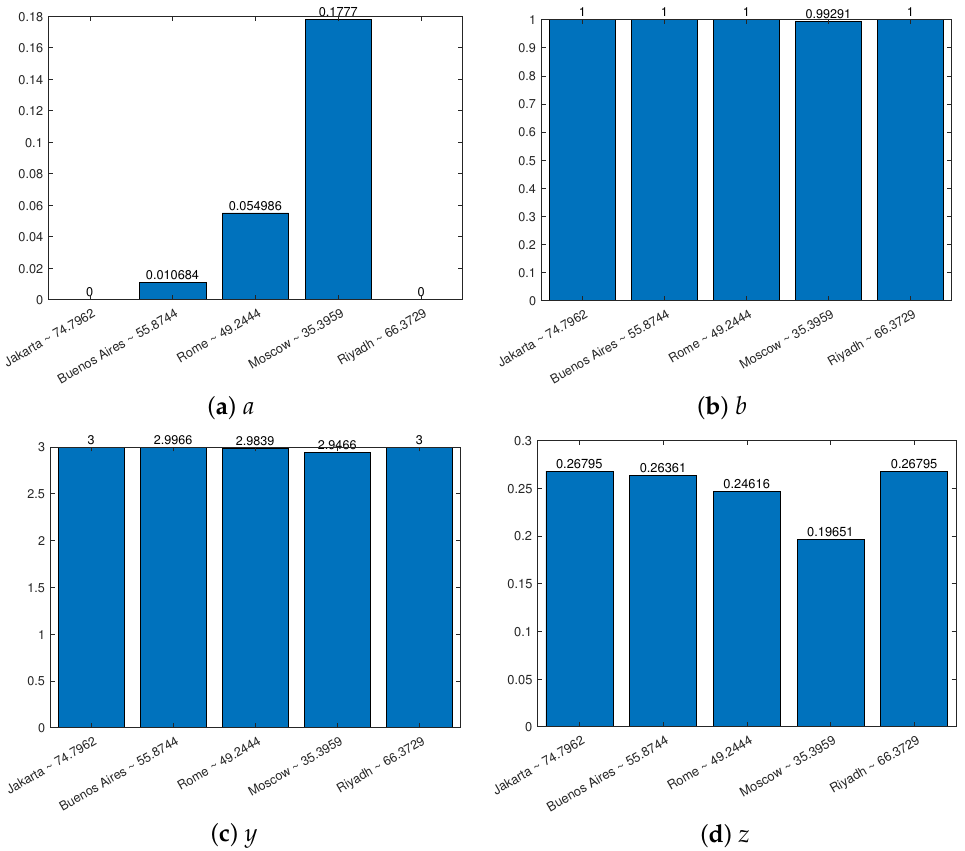
Figure 8. Weighted average values of parameters ( a , b , y , z ) with respect to each region in Table 3. Note that the number displayed after the city is the weighted average value of the south meridian